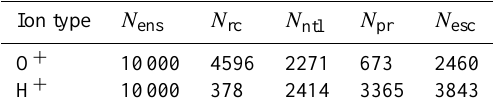
Table 2. Distribution to the ring current ( N rc ), near-tail ( N ntl ), pre- cipitating ( N pr ) and escaping ( N esc ) O + and H + populations of test ions injected from the plasma sheet, with initial conditions for r in [18 R E , 22 R E ], E k in [2 , 6]keV and θ in [20 , 30] ◦ . Ion type N ens N rc N ntl N pr N esc O + 10000 4596 2271 673 2460 H + 10000 378 2414 3365